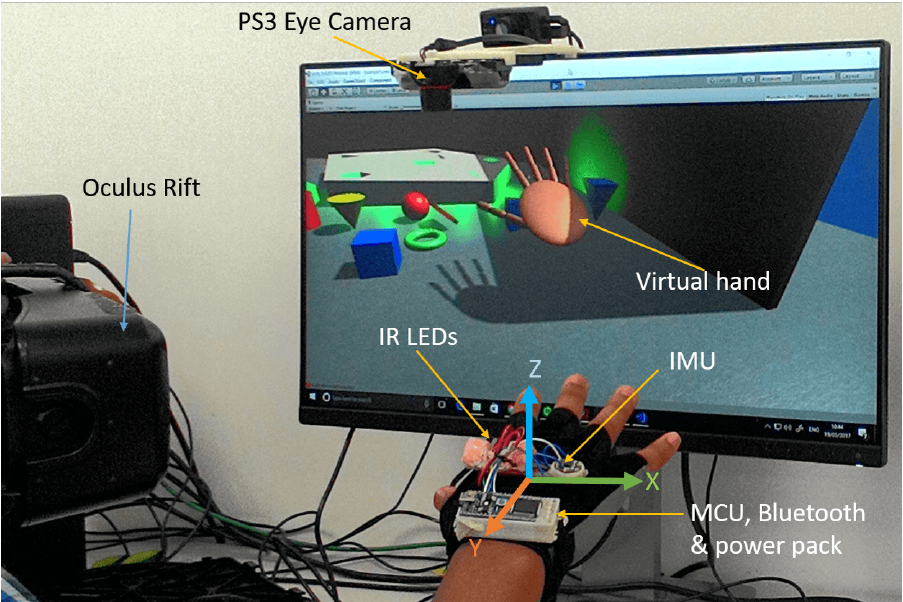
Figure 1. Virtual reality 6 Degree of Freedom (6-DOF) tracking experimental